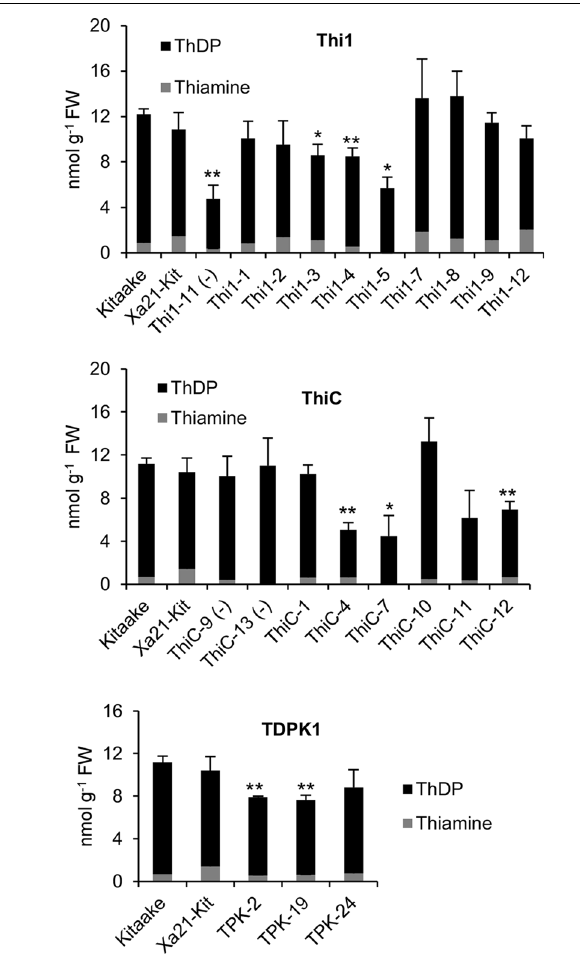
FIGURE 4 | Thiamin and ThDP concentrations in leaves of T 1 THI1, THIC, and TDPK1 lines. Each individual plant was PCR genotyped for the presence of the corresponding gene. Negative signs in parenthesis indicate rice lines that were genotyped negative. Wild-type Kitaake was used as a control. ThMP could not be detected in any sample. Xa21-Kit, Kitaake expressing XA21 , a gene that confers strong resistance to Xanthomonas oryzae pv. oryzae . Data are means ± SE of at least three determinations. Asterisks indicate significant difference compared to the Kitaake control as determined by Student t -test ( ∗ p < 0.05; ∗∗ p < 0.01).